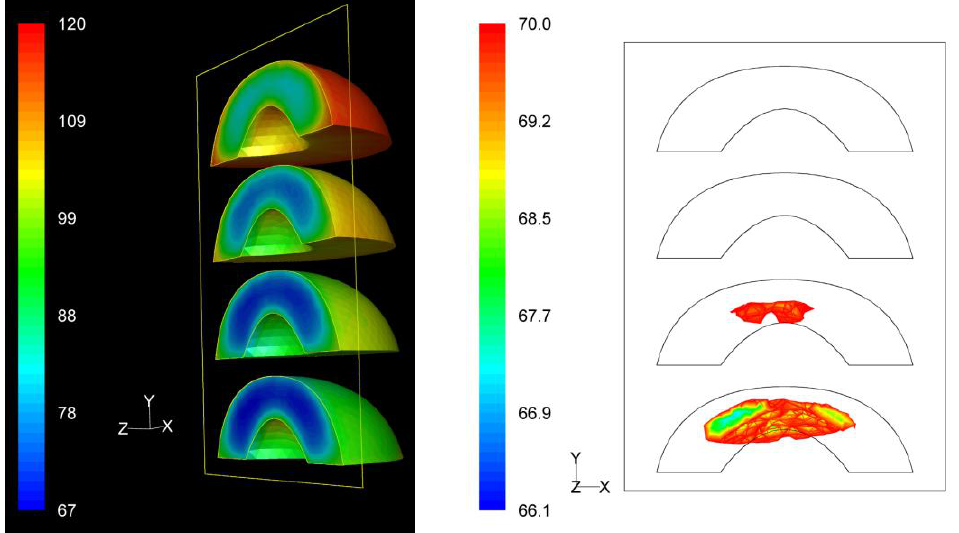
Figure 10. F value (in min) distribution within the peach halves (left) and location of the critical point (right) at the end of the thermal process for the “downward” case.